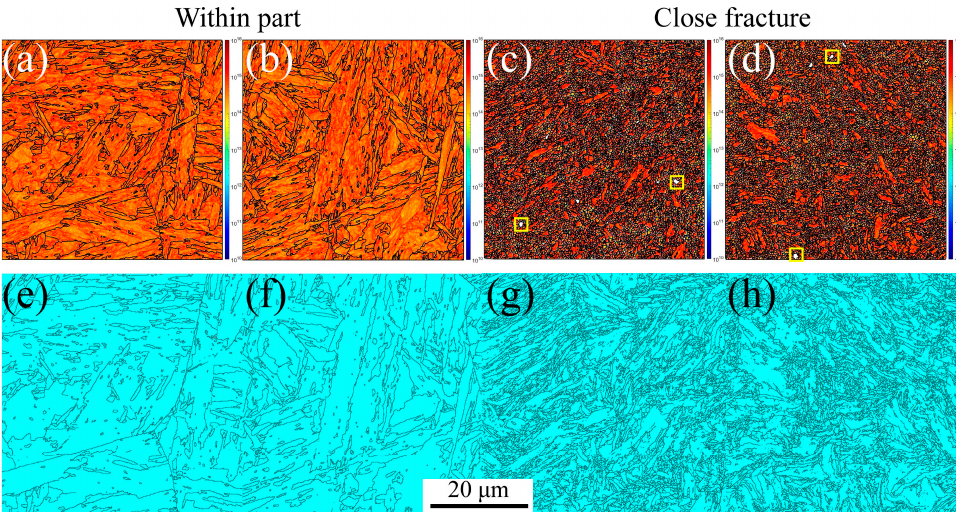
Figure 8. KAM, GND, and twinning maps under different strain gradients at the strain rate of 5 × 10 − 3 s − 1 under 430 and 630 °C (Voids are inside the yellow square). ( a – d ) GNDs and ( e – h ) twinnings. 5 × 10 − 3 s − 1 under 430 and 630 ◦ C (Voids are inside the yellow square). ( a – d ) GNDs and ( e – h ) 3.2.2. EBSD Maps and Analyses at a Strain Rate of 5 × 10 − 5 s − 1 under RT, 430 °C, and 630